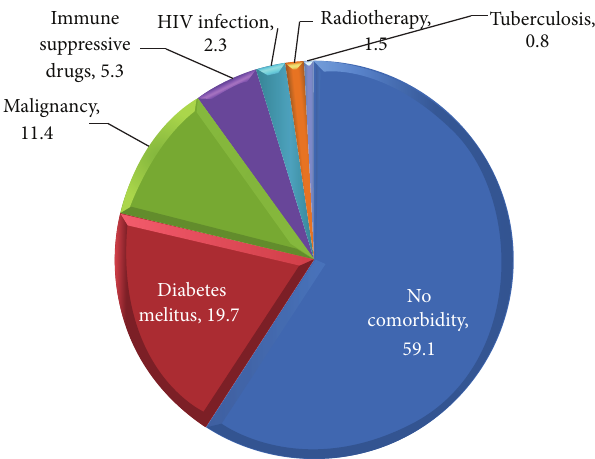
Figure 3: The prevalence of comorbidities in patients admitted with herpes zoster